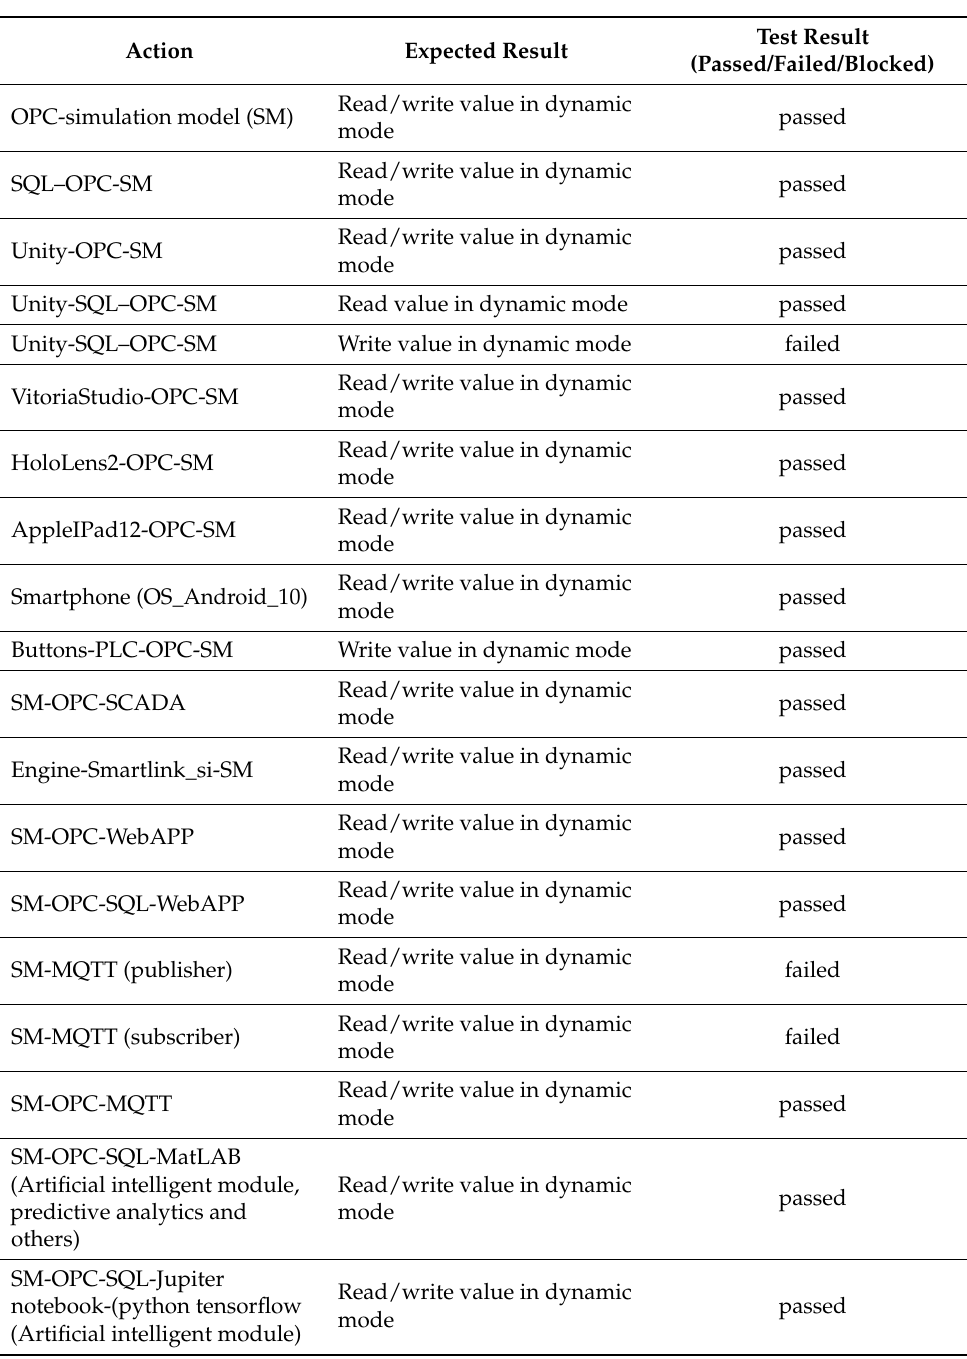
Table 8. Testing